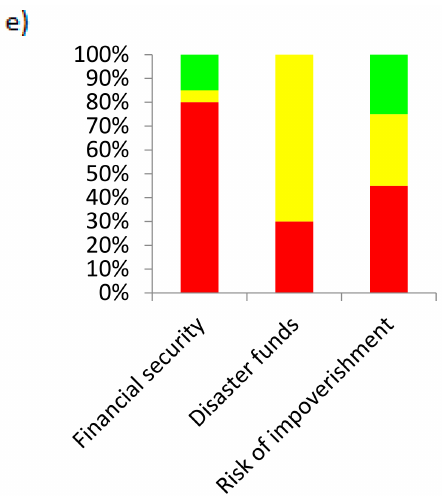
Figure 3. Assessment of the component factors of five capitals of local governance for water management in Quarry Road West informal settlement, Durban South Africa. Factors for each capital ranked from best to worst performing: ( a ) human capital; ( b ) environmental capital; ( c ) social capital; ( d ) political capital; and ( e ) financial capital. The assigned colors are according to performance relating to the traffic-light system: green for positive responses, yellow for varied responses, and red for negative responses.